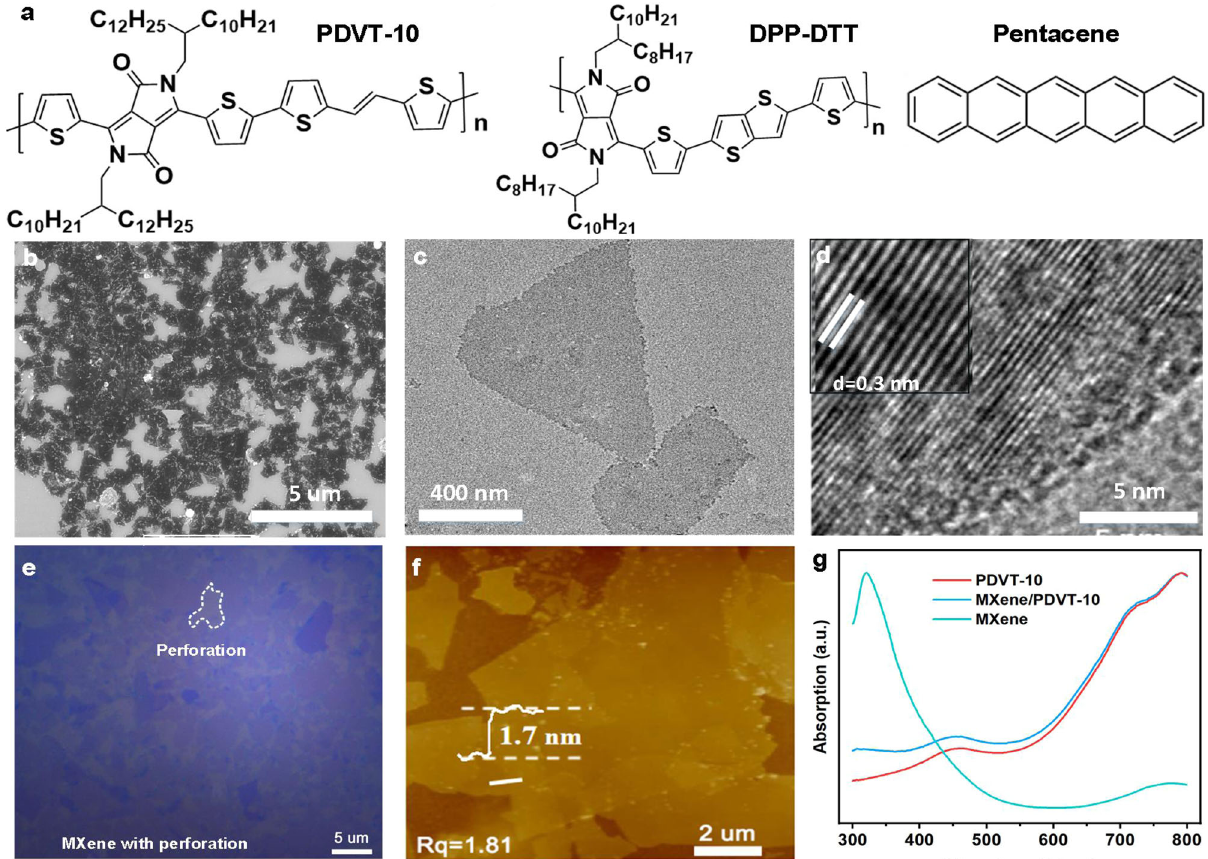
Fig. 1 Structure of semiconductor and characteristics of MXene fi lm. a The chemical structure of PDVT-10, DPP-DTT and pentacene. b SEM image of MXene fi lm with a concentration of 3 mg/ml. c TEM image of dispersive MXene nano fl ake. d HRTEM image of MXene. e Microscope image of MXene fi lm with perforation. f The AFM image of staked MXene. g The UV – vis absorption spectrum of MXene and PDVT-10. NATURE COMMUNICATIONS| (2022) 13:2898